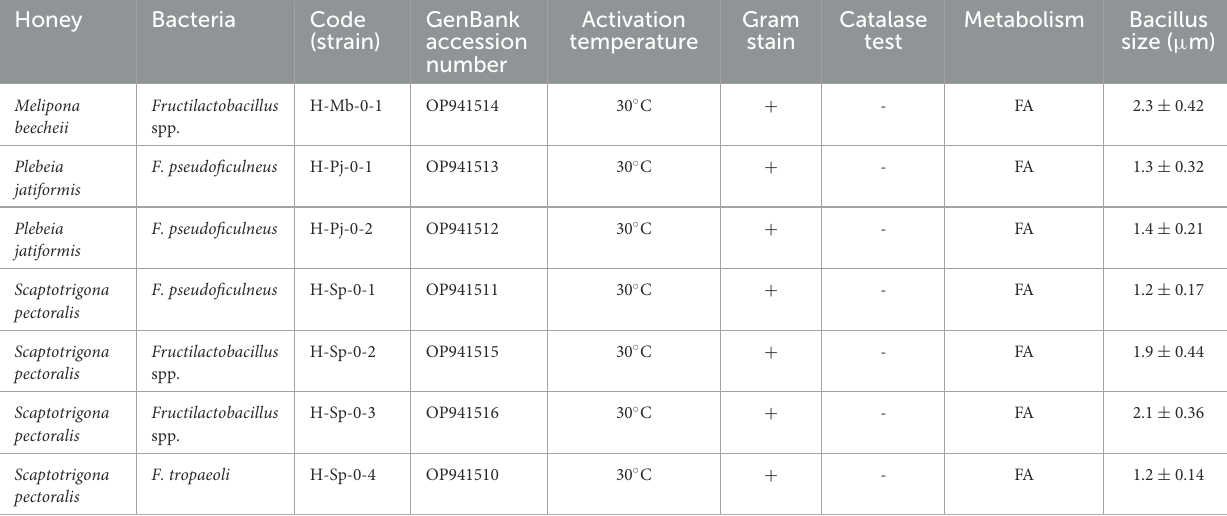
TABLE 2 Characteristics of bacteria isolated from stingless bee honey. Honey